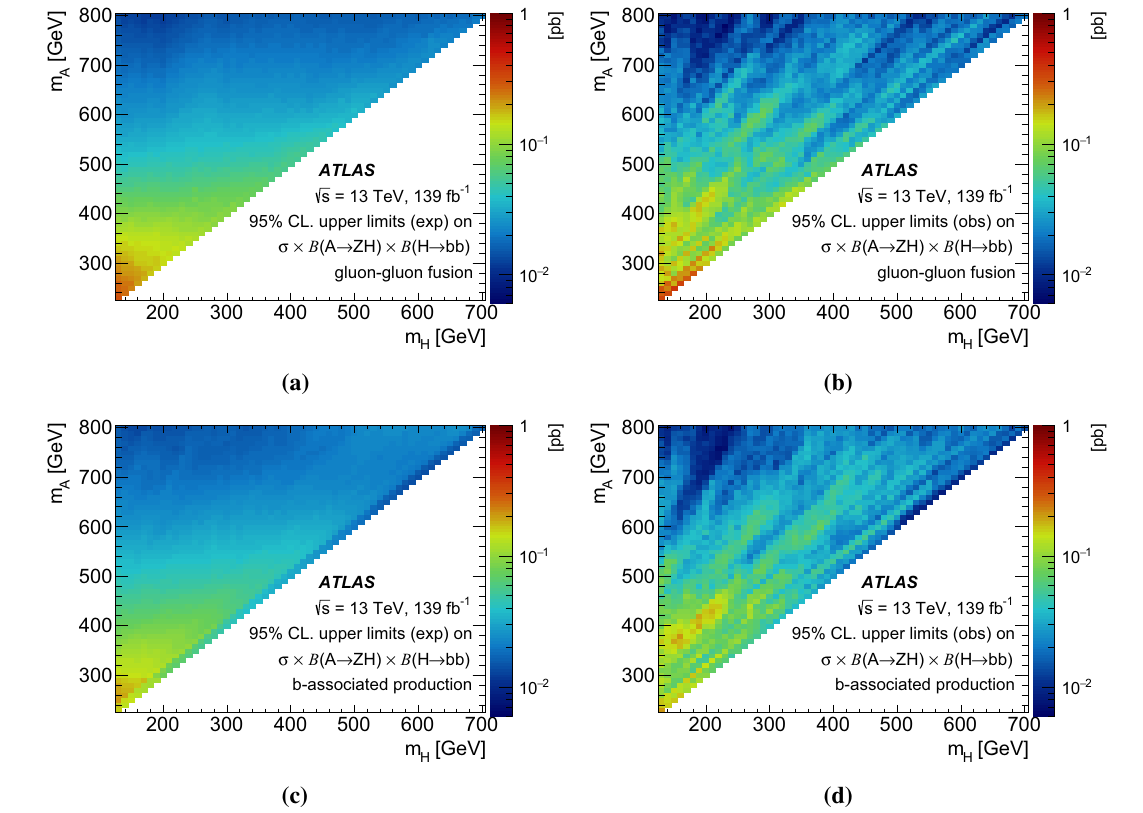
Fig. 9 Upper bounds at 95% CL on the production cross section times the branching ratio B ( A → Z H ) × B ( H → bb ) in pb for a , b gluon–gluon fusion and c , d b -associated production. The expected upper limits are shown in ( a ) and ( c ) and the observed upper limits are shown in b and d by a factor of approximately 3 from the narrow-width